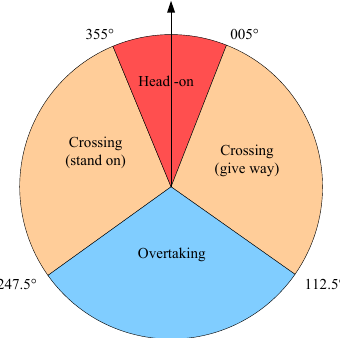
Figure 4. Ship encounter situation based on COLREGS.